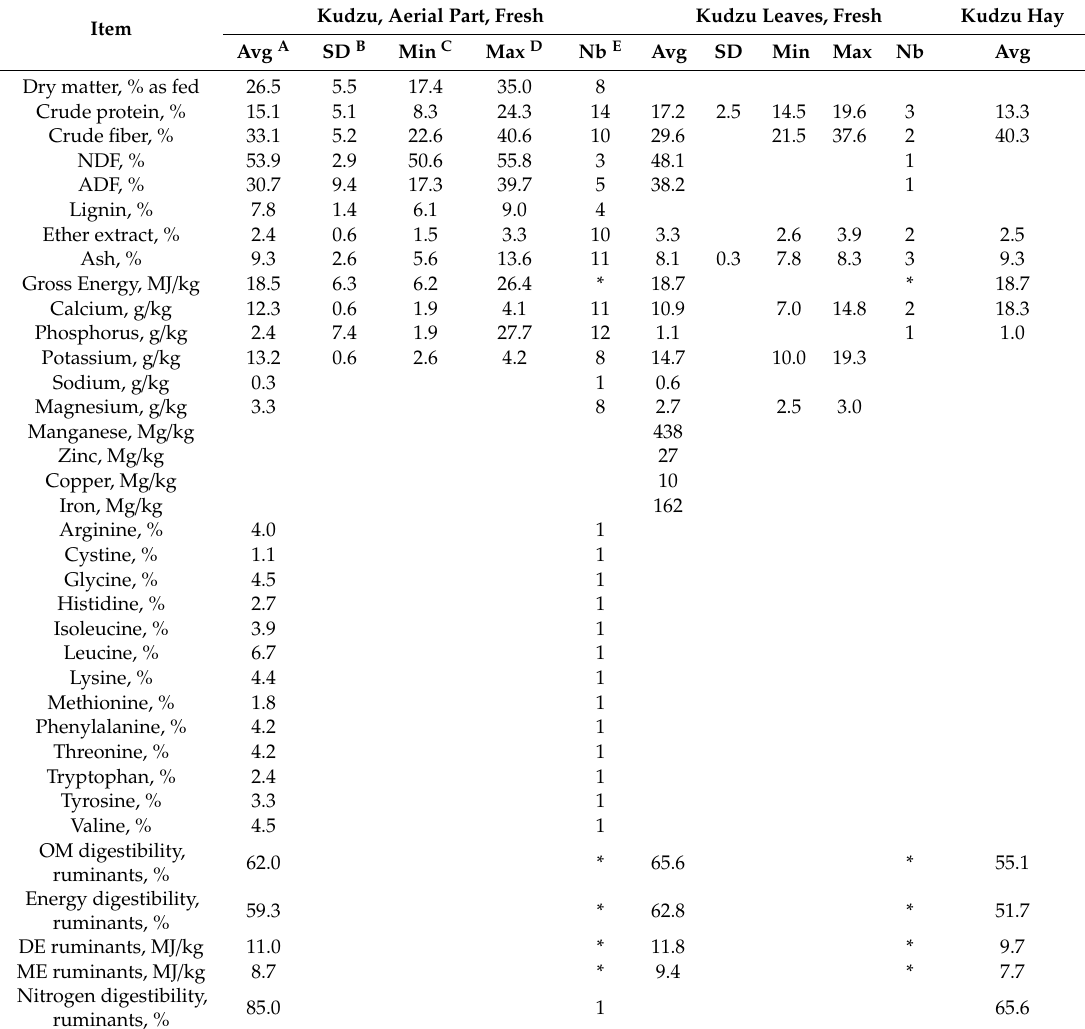
Table 3. Chemical and nutrient composition of kudzu ( P. montana ), aerial part, fresh, kudzu ( P. montana ) leaves, fresh, and kudzu ( P. montana ) hay (DM basis) [20,23–31]. Kudzu, Aerial Part, Fresh Item Dry matter, % as fed